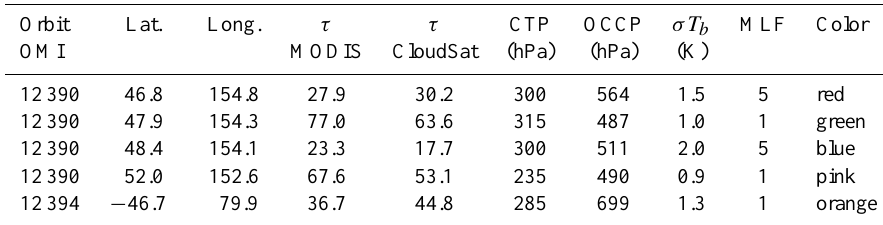
Table 3. Information corresponding to cloud extinction profiles shown in Fig. 10. MODIS τ is the MODIS 1km retrieved τ averaged over the OMI footprint; CloudSat τ is the 2B-Tau averaged over the along-track extent of the OMI pixel; CTP is the MODIS minimum cloud-top pressure within the OMI footprint. Orbit Lat. Long. τ τ CTP OCCP σT b MLF Color OMI MODIS CloudSat (hPa)